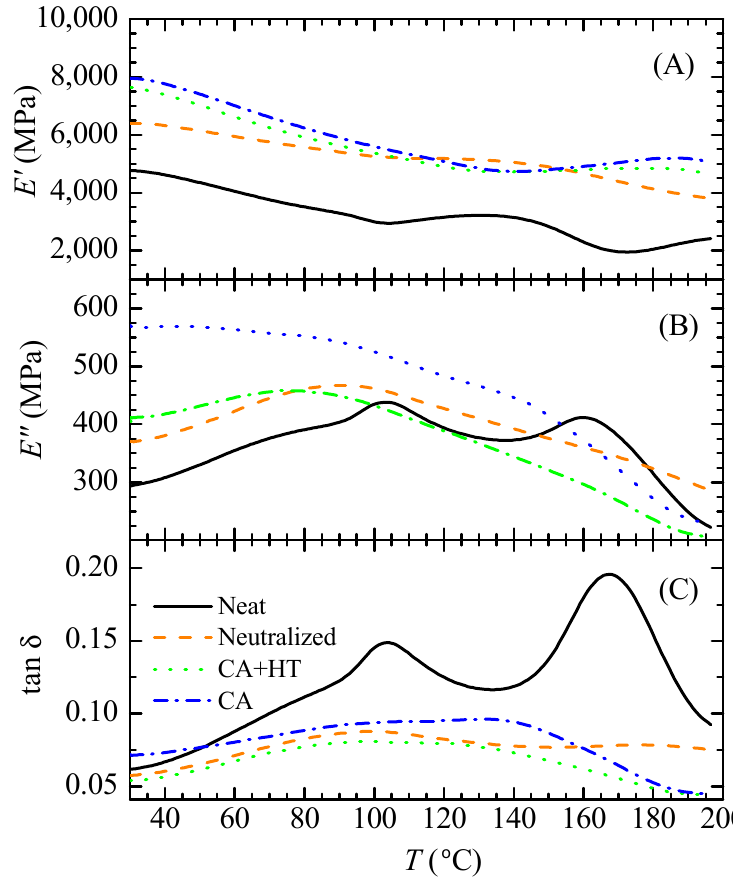
Figure 3. The plots of ( A ) storage modulus, ( B ) loss modulus, and ( C ) tan δ against temperature of neat, neutralized, CA, and CA-HT films with no preheating.